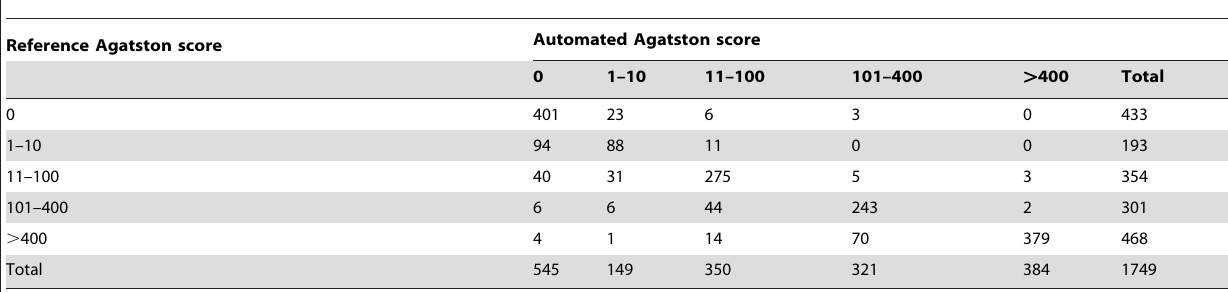
Table 1. Agatston Risk Category Shift between reference and automated scores.